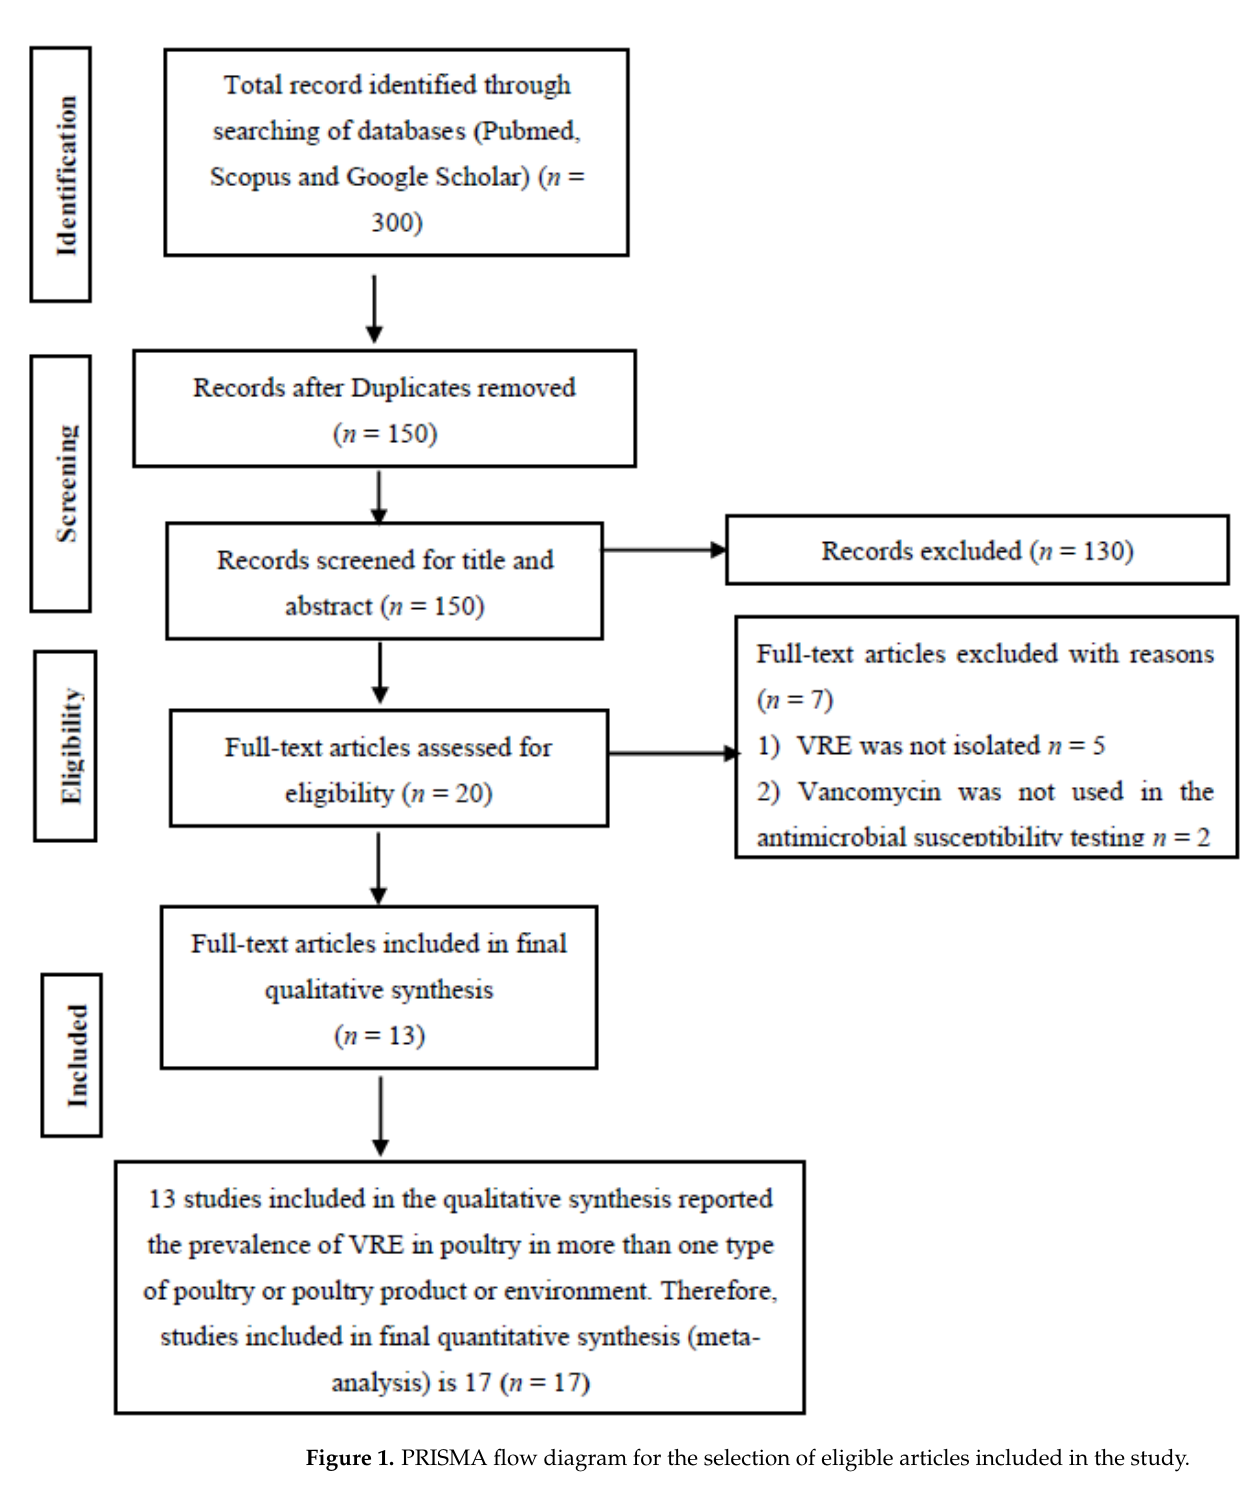
Figure 1. PRISMA flow diagram for the selection of eligible articles included in the study.